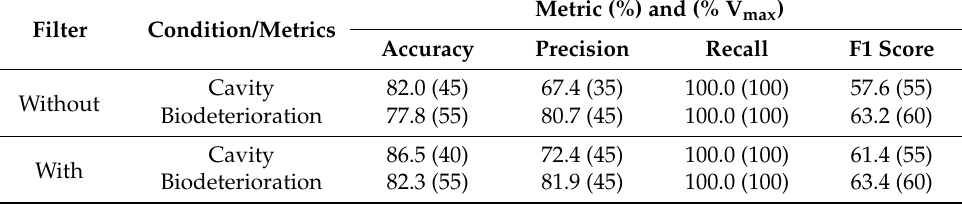
Table 4. Maximum percentages of the metrics of the confusion matrix and respective percent- ages of the maximum velocity (% V max ) obtained for zones of interest (cavity—Ca or cavity plus biodeterioration—Ca+Bio), using or not using filters in the images. Interpolation algorithm: Ellipses without